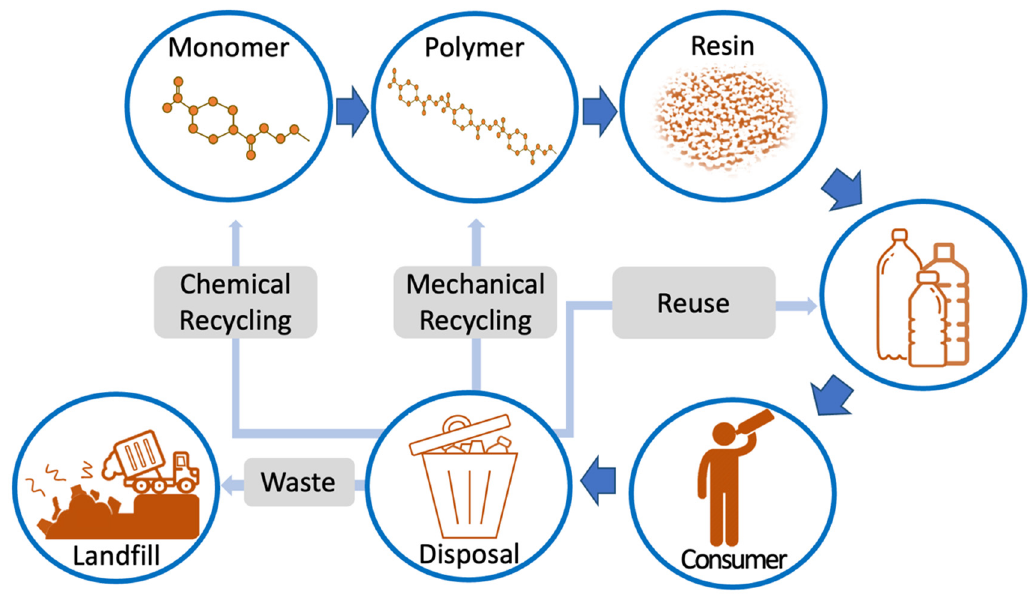
Figure 2. Plastic packaging life cycle of polyethylene terephthalate (PET) bottle.